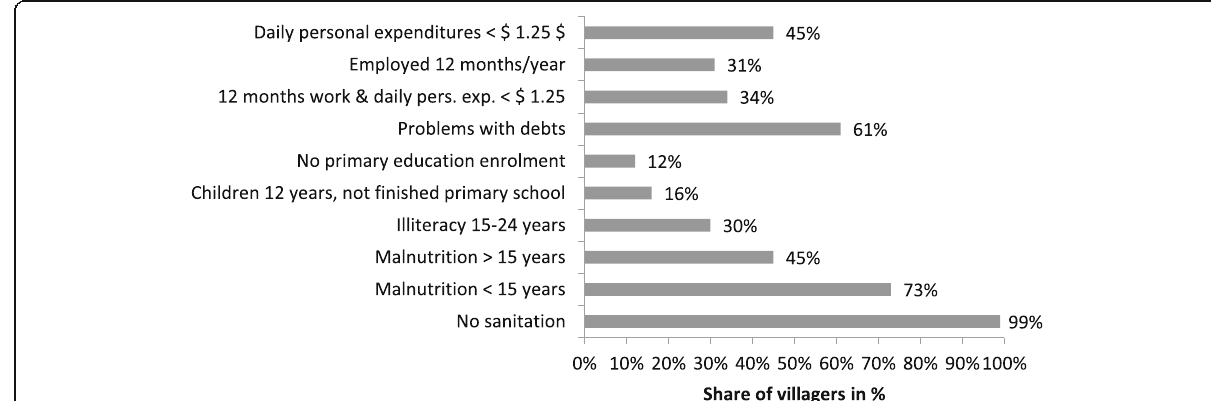
Fig. 1 Reported deprivation in multiple dimensions in % of the village population. Source: MVP Panel Survey, baseline study 2011, own calculations. N > 2300, concrete numbers vary by issue. Malnutrition is measured by the Body Mass Index (BMI), a person is considered malnourished if the BMI is <